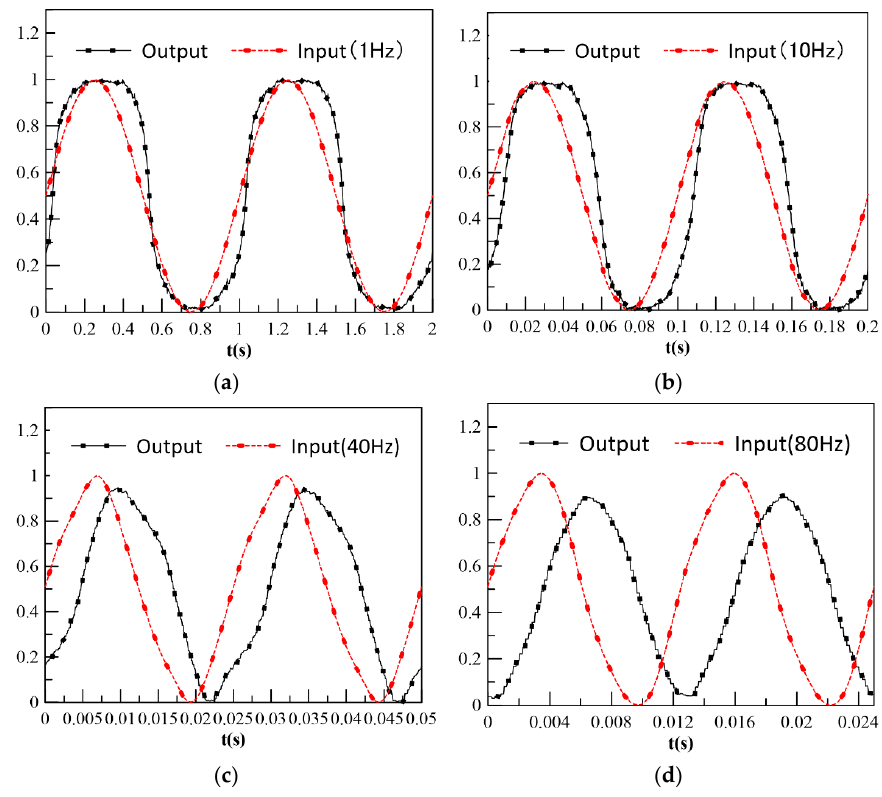
Figure 31. Sine wave following characteristics of CPMLTM. ( a ) 1 HZ, ( b ) 10 HA, ( c ) 40 Hz, ( d ) 80